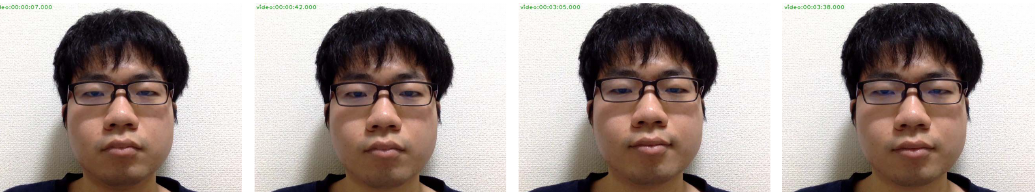
Figure 3. Samples of neutral face images to consider smile scale.